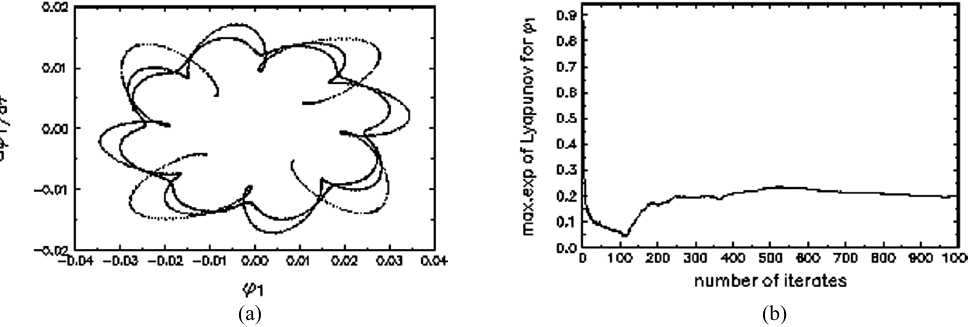
Fig. 12. Poincaré map (a) and Lyapunov exponents (b) of ϕ 1 for γ 4 = 0.0005 and for: a 1 = a 2 = 0.1; a 3 = 0.0001; γ 1 = 0.0001; γ 2 = γ 3 =